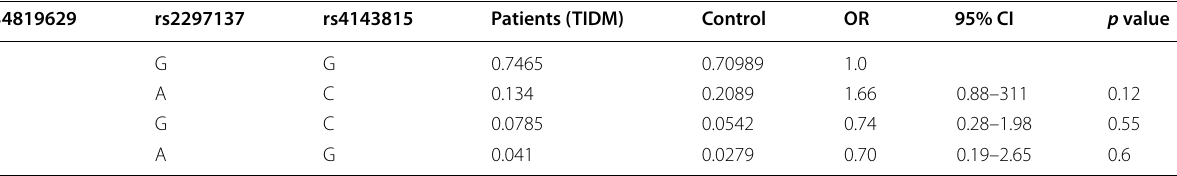
Table 6 Haplotype frequency analysis of rs34819629, rs2297137, and rs4143815 and its association with risk of type 1 diabetes